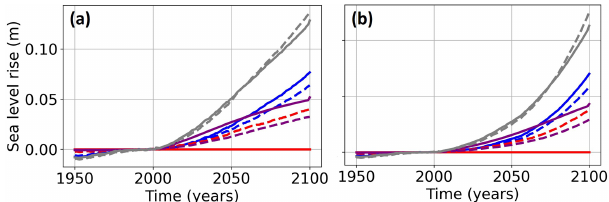
Figure 2. Projected changes up to 2100 (relative to 1986–2005) of dominating barystatic SLR contributions scaled to the IBI do- main using their spatial fingerprints for the (a) SSP1-2.6 scenario (b) SSP5-8.5 scenario. The SL contributions evaluated here are the Antarctic ice-sheet contribution (blue), the Greenland ice-sheet con- tribution (red), the glaciers’ contribution (purple) and their sum (gray). The dashed lines represent the initial CNRM-CM6-1-HR contributions and the solid lines the contributions based on Op- penheimer et al. (2019) for the Antarctic ice sheet and on Hock et al. (2019) for